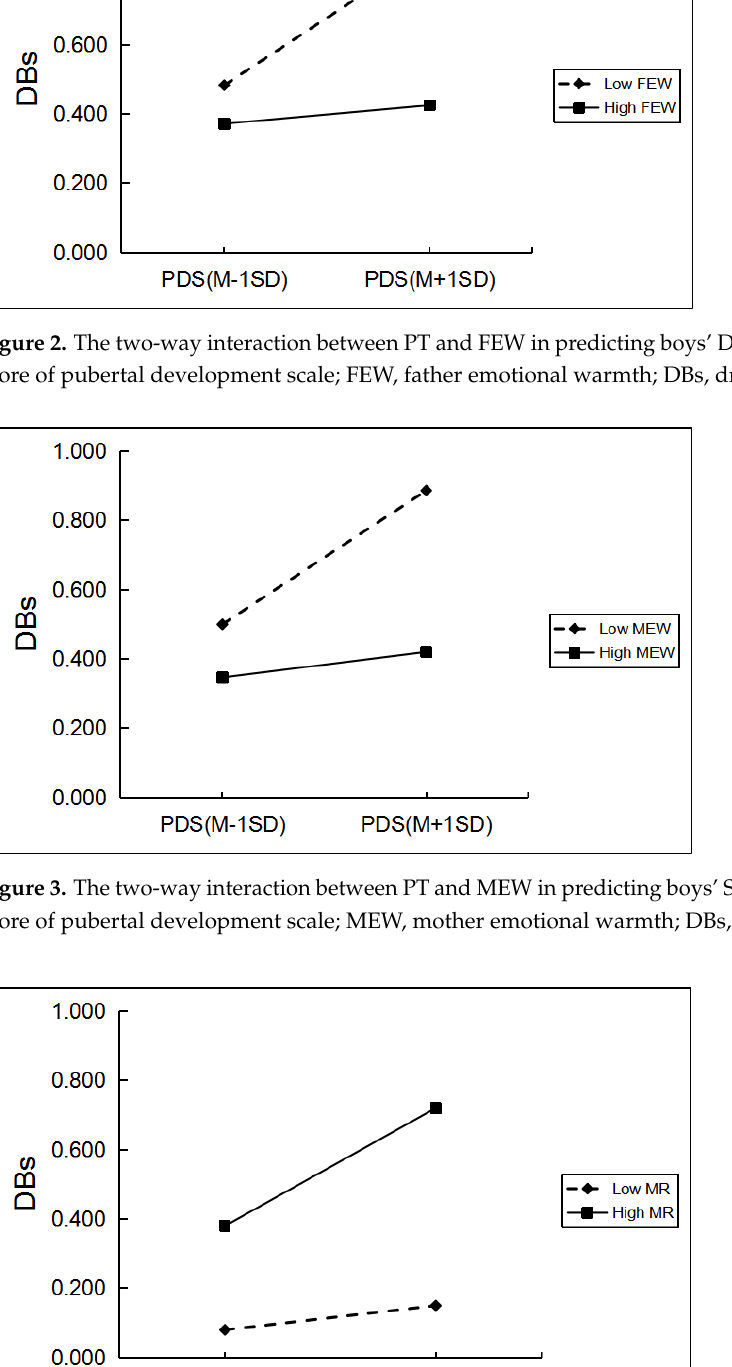
Figure 5. The two- way interaction between PT and MOP in predicting girls’ DBs. Note: PDS, the total score of pubertal development scale; MOP, mother over-protection; DBs, drinking behaviors. Figure 6. The two- way interaction between PT and MEW in predicting girls’ DBs. Note: PDS, the total score of pubertal development scale; MEW, mother emotional warmth; DBs, drinking behav- iors. 4. Discussion The current study investigates parenting practices as a moderator between early pu- bertal timing and adolescent drinking behavior. The results show that adolescents’ early